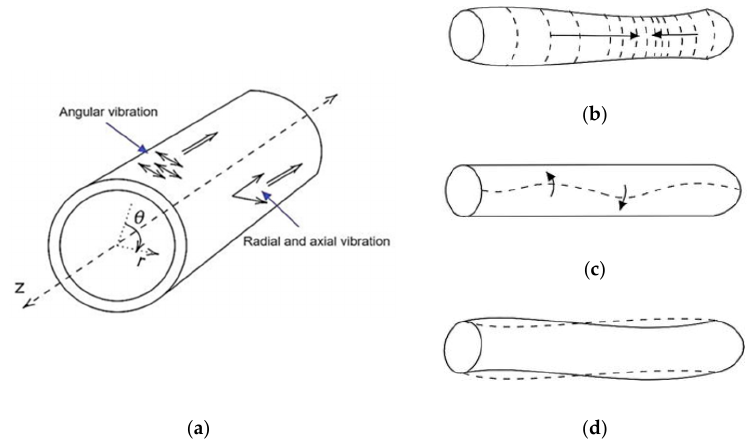
Figure 1. Illustration of the low-frequency mode shapes in cylindrical co-ordinates: ( a ) wave motion; ( b ) longitudinal mode; ( c ) torsional mode; ( d ) flexural mode [59].